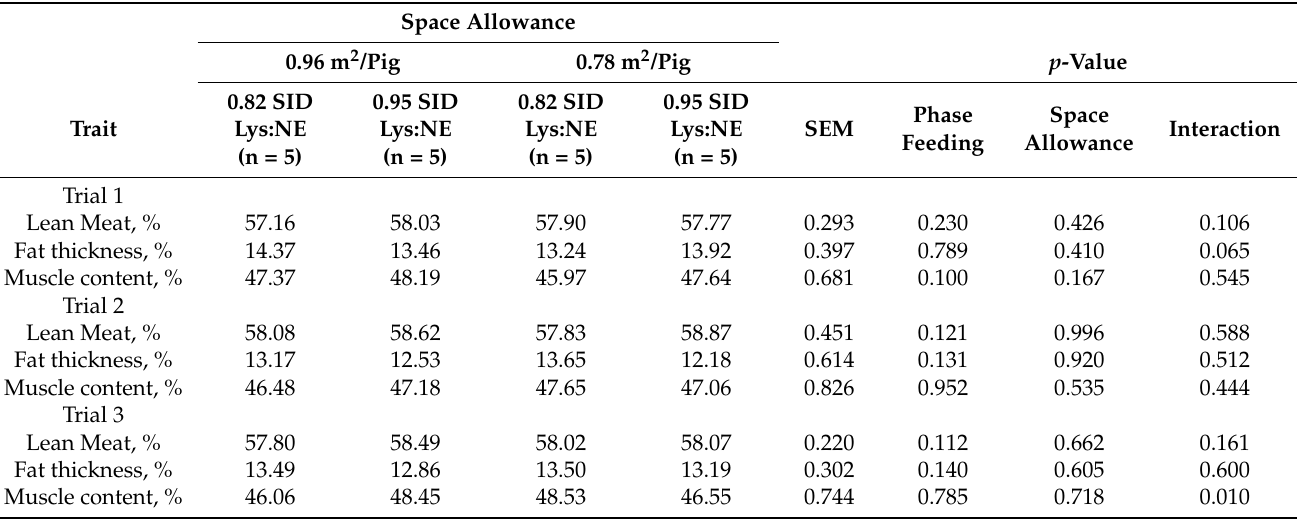
Table 6. Effect of space allowance and phase feeding on lean meat %, fat thickness and muscle content (Least square means (LS means) ± Standard error mean (SEM)) from trial 1, 2 and 3 1 . Space